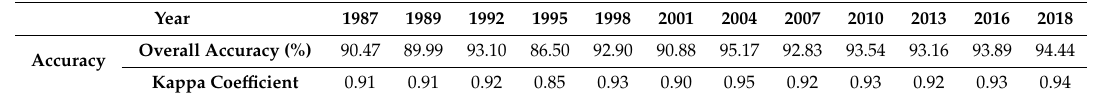
Table 5. The accuracy of the